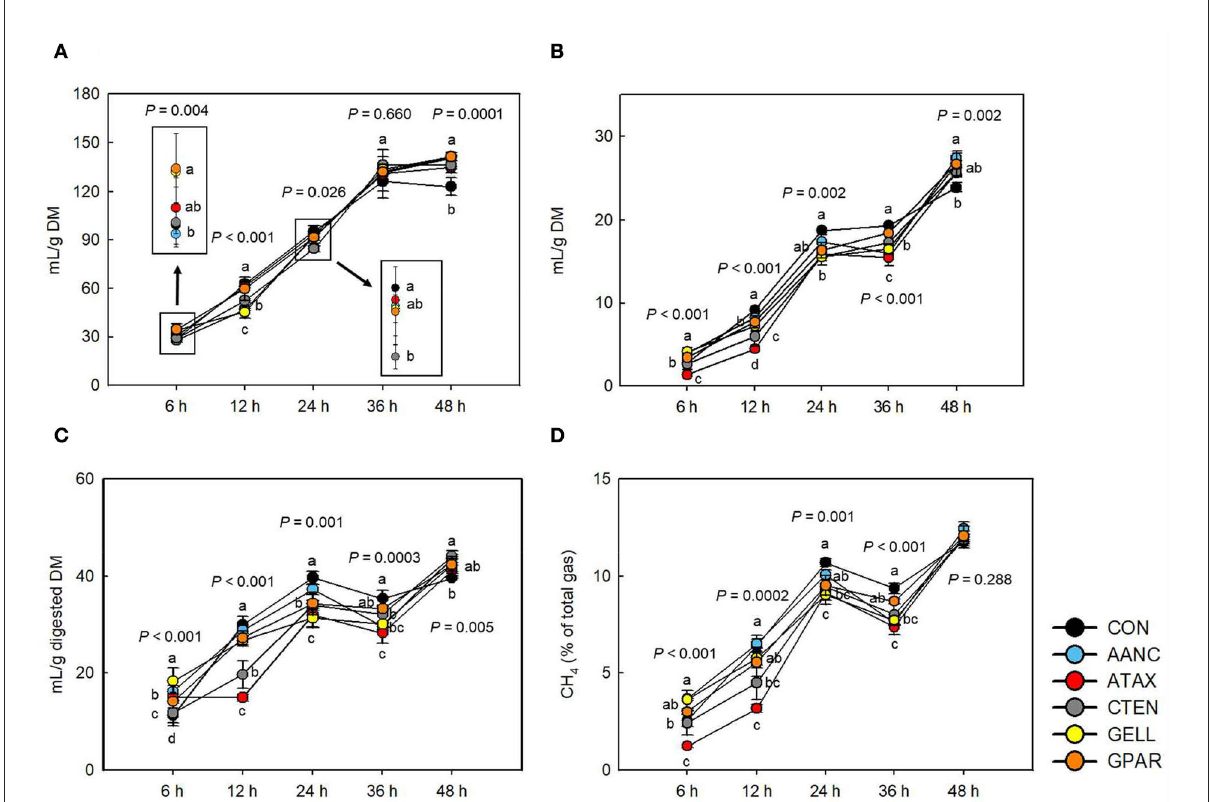
FIGURE3 Effects of red seaweed extracts on in vitro total gas and methane production. CH 4 , methane; DM, dry matter; CON (black circle), without seaweed extracts; AANC (sky blue circle), Amphiroa anceps ; ATAX (red circle), Asparagopsis taxiformis ; CTEN (dark gray circle), Chondracanthus tenellus ; GELL (yellow circle), Grateloupia elliptica ; GPAR (orange circle), Gracilaria parvispora. Data were analyzed using seaweed extracts dose amounts: 0.25 mg/mL, 0.25 mg/mL, based on a 5% basis of substrate mixture. Bars represent the standard error of triplicate analysis. P -values represent multiple comparison output of each incubation time. a − c Means ( n = 3) with different superscript letters indicate a significant difference ( P < 0.05). (A) Total gas (mL/g DM), (B) CH 4 (mL/g DM), (C) CH 4 (digested DM), and (D) CH 4 (% of total gas).